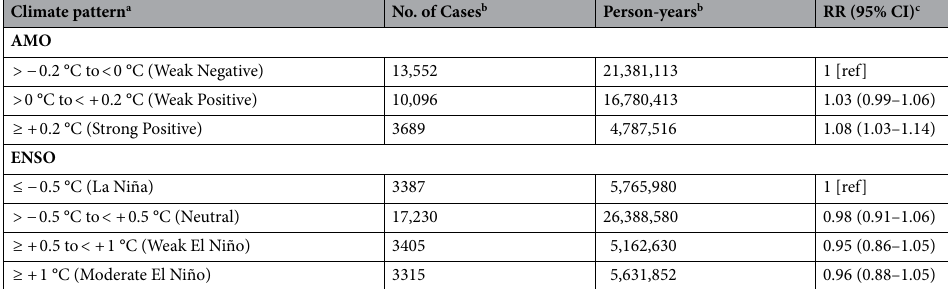
Table 1. Association between summer Atlantic Multidecadal Oscillation (AMO) or El Niño Southern Oscillation (ENSO) categories and ischemic heart disease mortality rates among older adults in the United Kingdom, 2010–2017. a AMO and ENSO were run as separate models (i.e. not controlled for each other). b Both sexes combined. c Rate ratio after adjusted for the year and